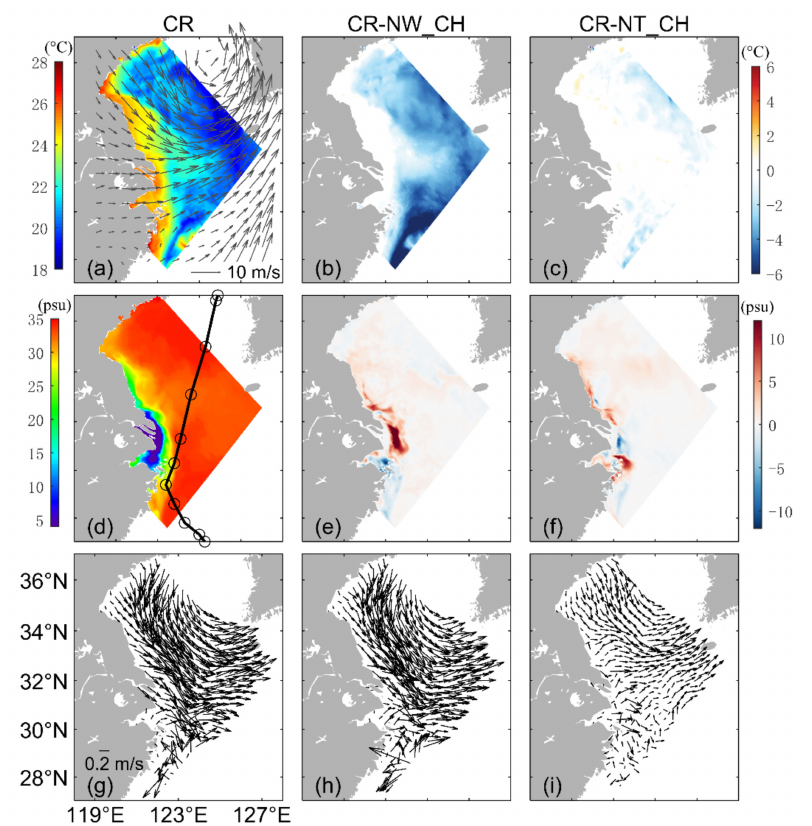
Figure 19. Distribution of simulated daily mean ( a ) SST, ( d ) SSS and ( g ) sea surface currents produced by the inner model in the case of CR on 12 July 2015, and differences in SST ( b , c ), SSS ( e , f ) and sea surface currents ( h , i ) between cases CR and NT_CH and cases CR and NW_CH. Grey arrows in ( a ) represent daily mean wind vectors at 10 m on 12 July 2015. The black line in ( d ) represents the storm track of Typhoon